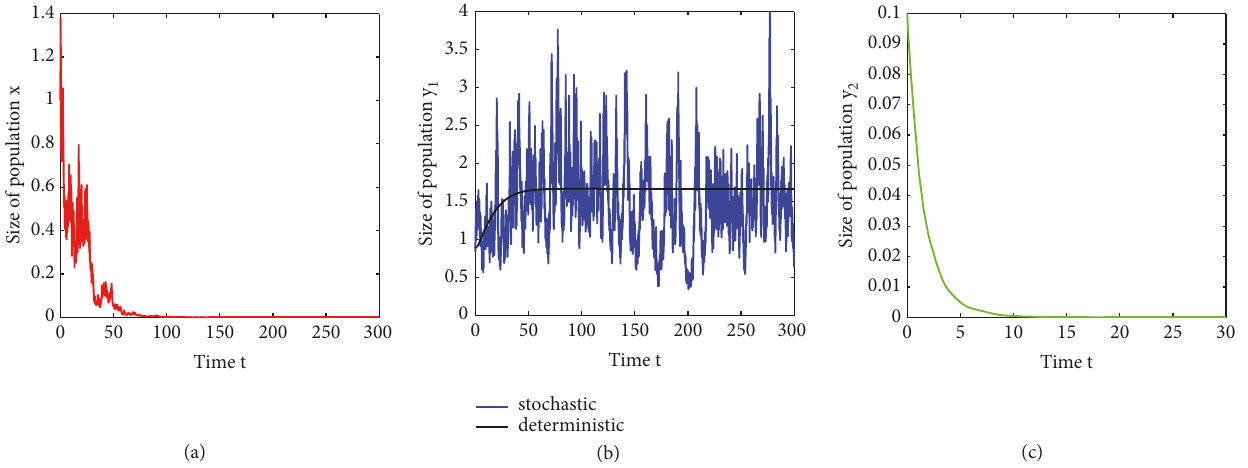
Figure 3: Numerical simulation of the solution of model (6). The parameters of model (6) are 𝑎 = 0.55 , 𝑏 = 0.3 , 𝑐 = 0.38 , 𝜂 = 0.6 , 𝑑 = 0.5 , ̂𝑒 = 0.23 , 𝑓 = 0.3 , 𝛿 = 0.1 , 𝑔 = 0.5 , and 𝜎 2